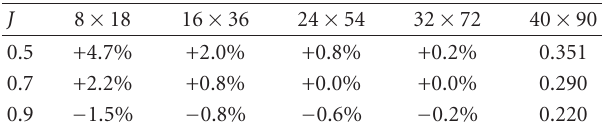
Table 1: Deviation of kt to value of finest grid for the BEM grid study.